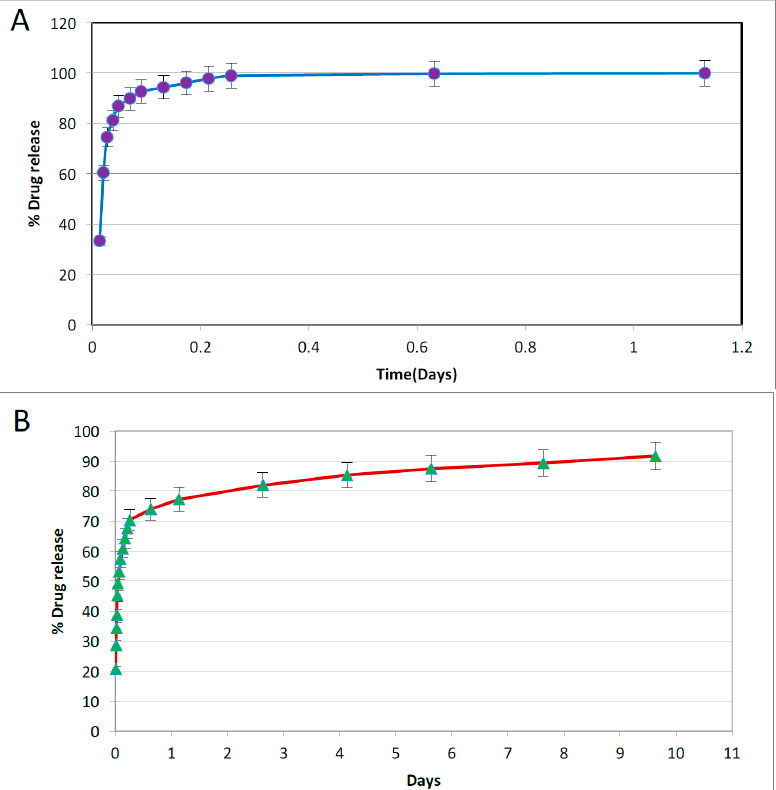
Figure 6. ( A ) Brilliant Green release from loaded halloysite-PCL scaffolds; ( B ) Amoxycillin and potassium calvulanate release from loaded halloysite-PCL scaffolds. n = 3 trials.